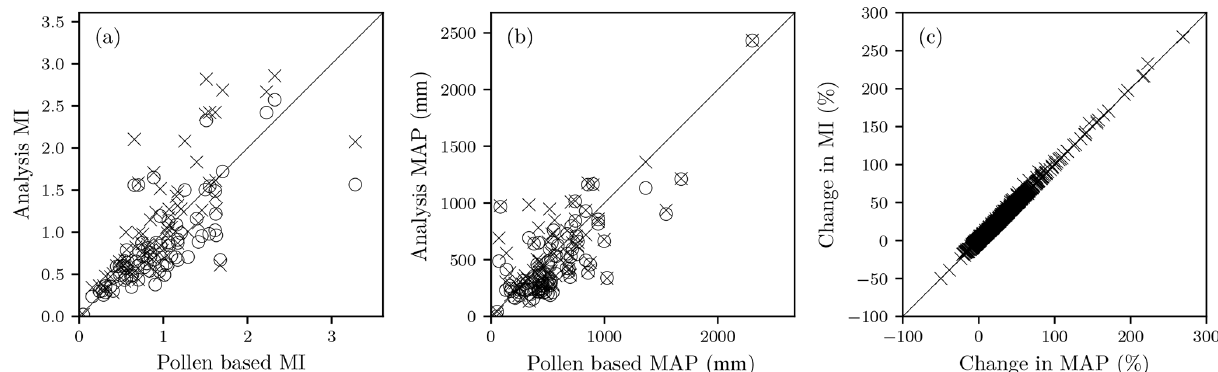
Figure 5. Impact of [CO 2 ] on reconstructions of moisture-related variables. The individual plots show (a) the change in moisture index (MI) and (b) the change in mean annual precipitation (MAP) compared to the original pollen-based reconstructions for the LGM before (circles) and after (crosses) the physiological impacts of [CO 2 ] on water-use efficiency are taken into account. The third plot (c) shows the relative difference between MI and MAP as a result of [CO 2 ], shown as the percentage difference between the no-[CO 2 ] and [CO 2 ]